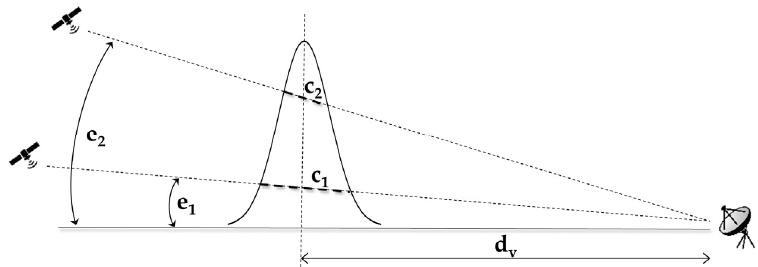
Figure 6. Cross-sections of the rain cell ( c 1 , c 2 ) when satellites are received with different elevation angles e 1 and e 2 .